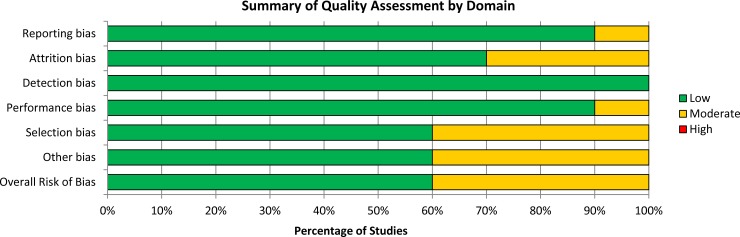
Summary of the quality assessment, via the cochrane risk of bias tool, for the identified RCTs reporting on NMBAs (quality assessment was possible for 10 studies for which full-text publications were available).Legend: The green, yellow and red colors in this figure respectively indicate low, moderate and high risk of bias. Abbreviations: NMBA: neuromuscular blocking agent; RCT: randomized controlled trial. For each domain, the percentage of studies deemed at low risk of bias was: reporting bias: 90%; attrition bias: 70%; detection bias: 100%; performance bias: 90%; selection bias: 60%; and other bias: 60%. None of the studies were deemed at high risk of bias for any domain.